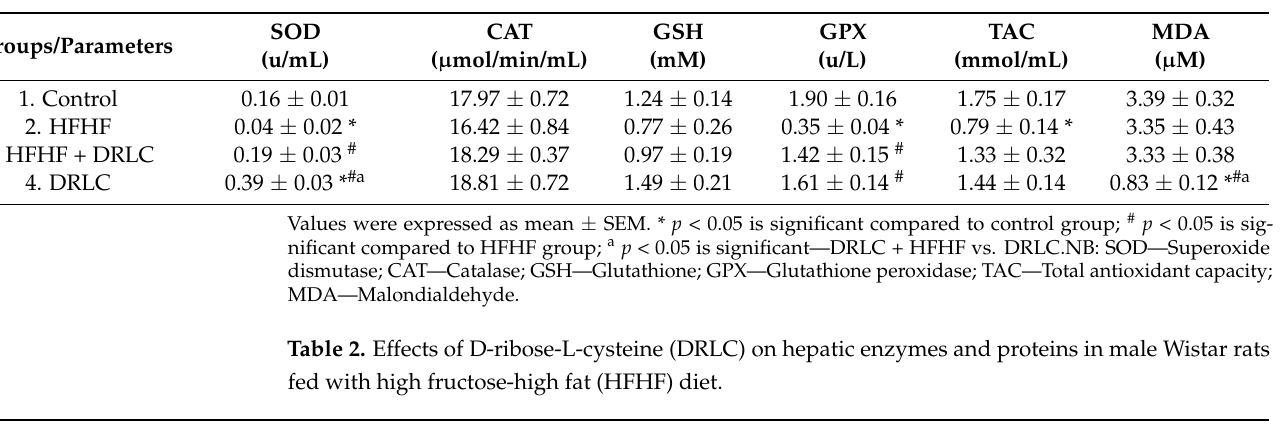
Table 1. Effects of D-ribose-L-cysteine (DRLC) on antioxidant/pro-oxidant indices in male Wistar rats fed with high fructose-high fat (HFHF) diet.